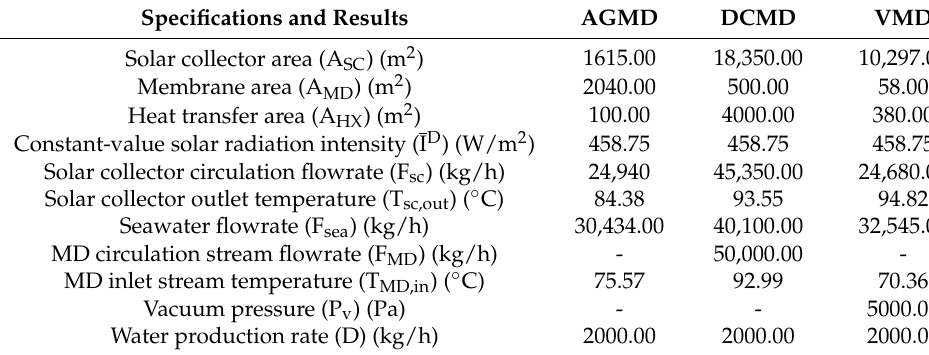
Table 3. The equipment sizes and operation conditions of a representative case for each SDMD